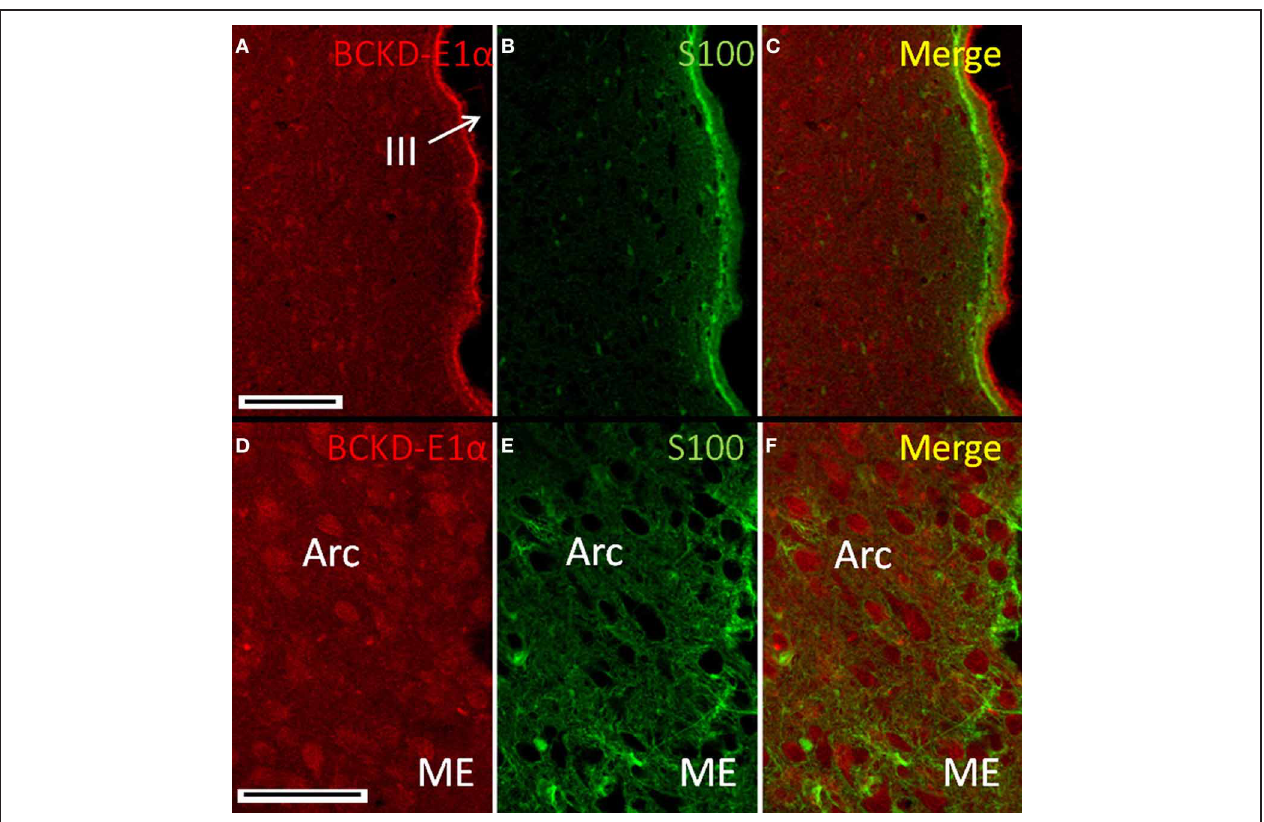
near the transition to the median eminence (ME). (E) Immunolabel for S100 in the same section as in panel D . (F) Merged image of panels D and E . Neurons of the arcuate nucleus are labeled for BCKDC, with no overlap of labeling for S100. S100 labeling appears in occasional cells of the nucleus, as well as in processes of cells lying in the transition zone to the median eminence. Scale bars: (A–C) 100 μ m. (D–F) 50 μ